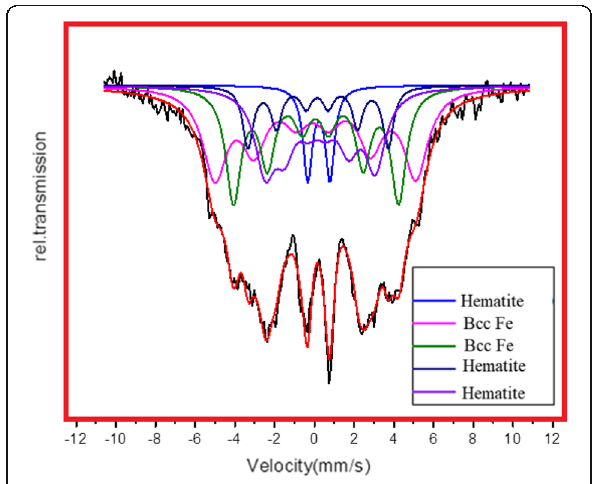
Fig. 10 Mössbauer spectra of Fe NCs-6 at 320 K